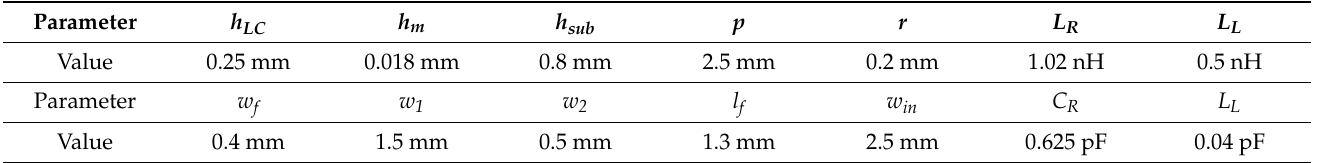
Figure 3. Schematic diagram of the CRLH unit cell: ( a ) cross-section, ( b ) the parallel inductor structure, ( c ) the interdigital structure and ( d ) equivalent circuit diagram of the CRLH unit cell. Table 1. Parameters of the CRLH unit cells.